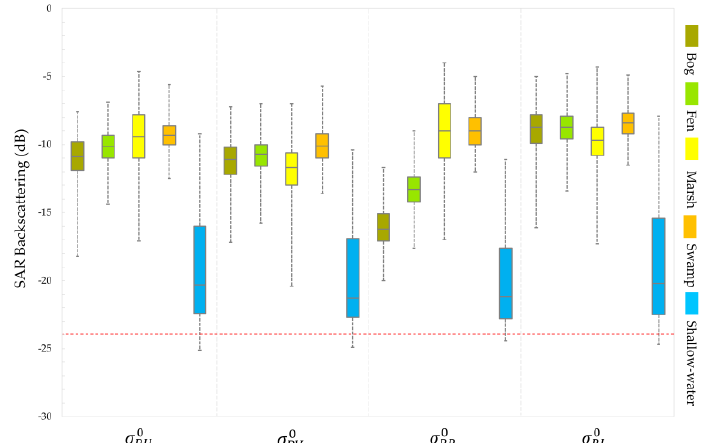
Figure 5. Box-and-whisker plots for extracted features from the Cloude-Pottier decomposition for wetland classes obtained from the pixel values of the training data set. Note: H: entropy, A: anisotropy, and 𝛼 : alpha angle.